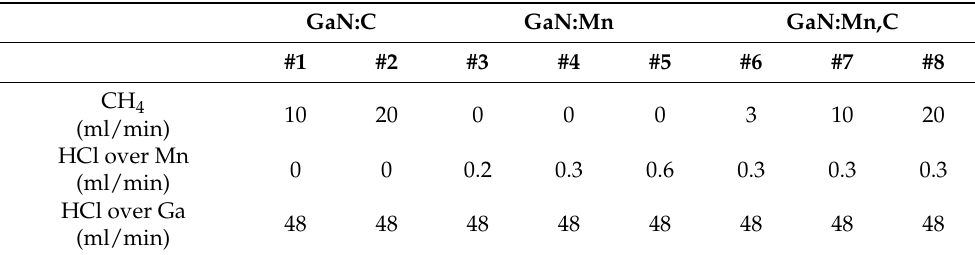
Figure 1. Scheme of the HVPE reactor configuration; GaCl, CH 4 , and MnCl x tubes were connected into one, allowing the reactants to mix and reach the growth zone by one quartz nozzle. Table 1. Technological parameters applied for growth of HVPE-GaN:C, HVPE-GaN:Mn, and HVPE-GaN:Mn,C.